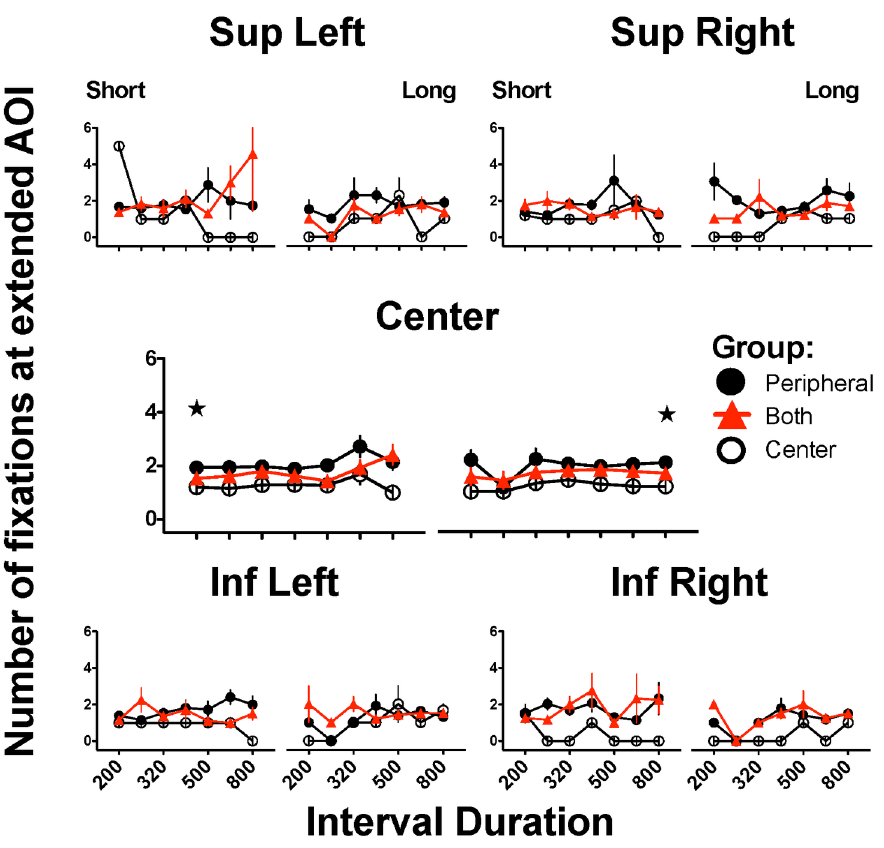
Fig 7. Fixations to extended Areas of Interest during generalization trials. Number of fixations to redefined (expanded) Area of Interest (AoI) where a stimulus could appear. For each AoI, left panels present the performance on trials where subjects categorized intervals as “ short ” and right panels correspond to categorizations as “ long ” ; only intervals close to or at the extreme durations present mean of 15 subjects since some subjects never emitted erroneous categorizations. Stars and horizontal bars indicate significant differences between denoted groups after two-way ANOVA followed by Bonferroni´s test (p < 0.05) (see text); only data from anchor intervals with N = 15 were included in statistical